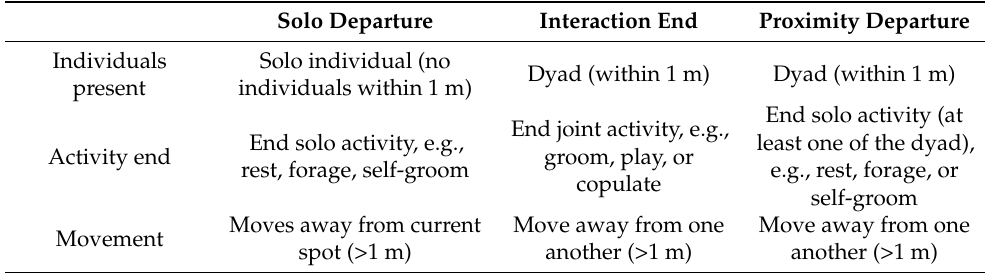
Table 1. Parting types and their